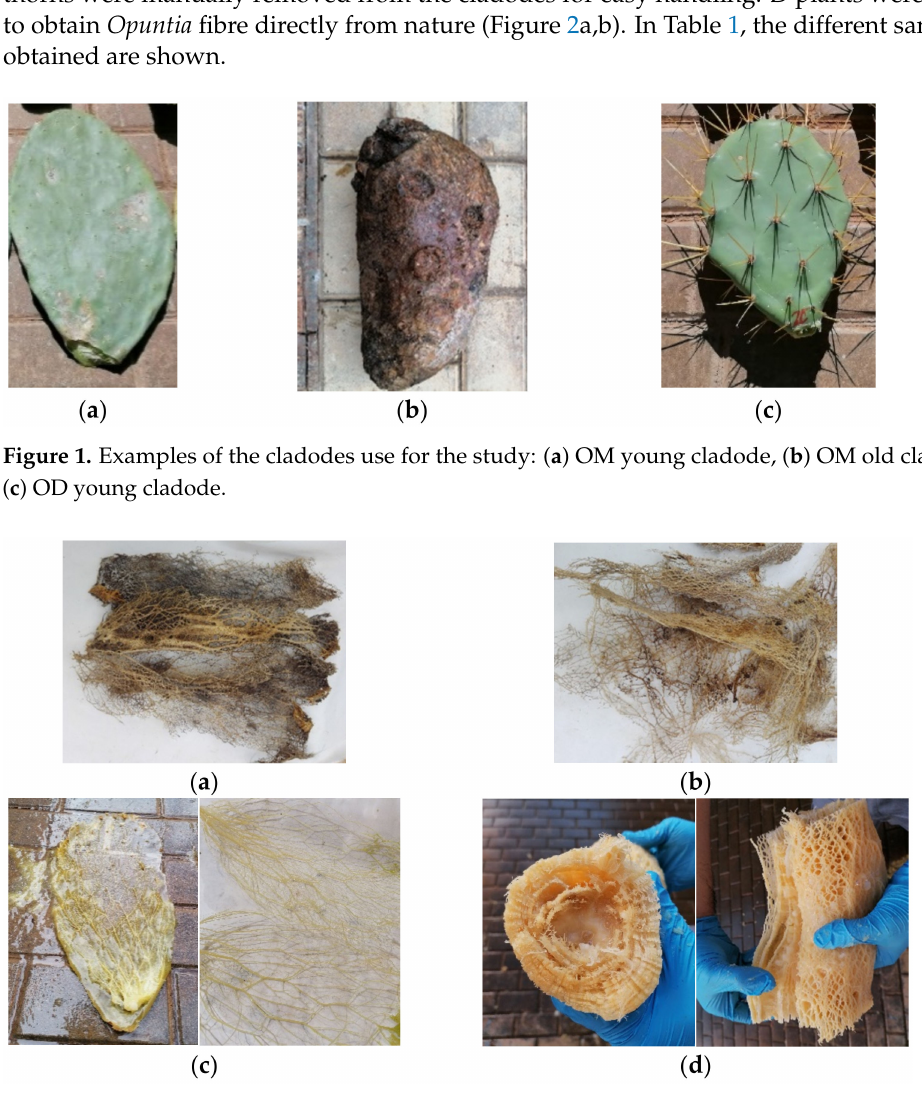
Figure 2. Fibre from Opuntia : ( a ) directly obtained from nature OM cladodes, ( b ) directly obtained from nature OD cladodes, ( c ) obtained by water retting process from young OM cladodes, ( d ) obtained by water retting process from old OM